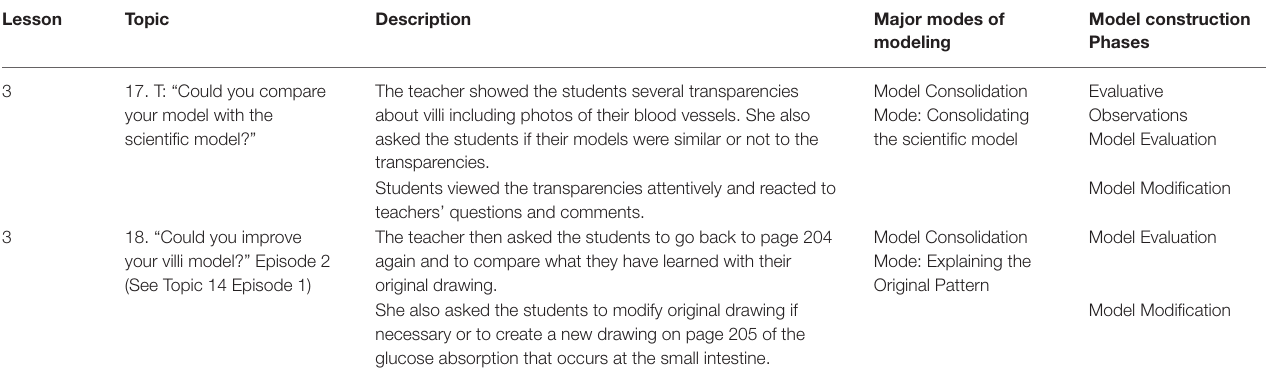
TABLE 7 | Model consolidation mode (part 5).